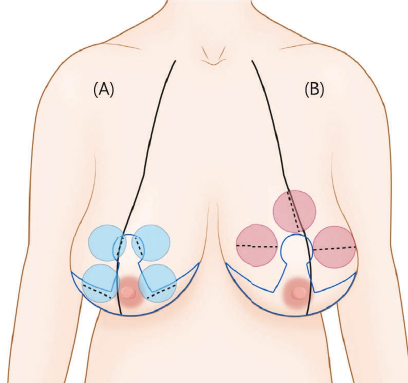
Figure 3: Incision location based on cancer location and reduction mammoplasty design. (a) When the breast cancer was located within the reduction mammoplasty design, the incision was made on the inner area of the design (dotted line) to prevent additional scarring. (b) When the breast cancer was located outside of the reduction mammoplasty design, the incision was made at the midline of the cancer locations.